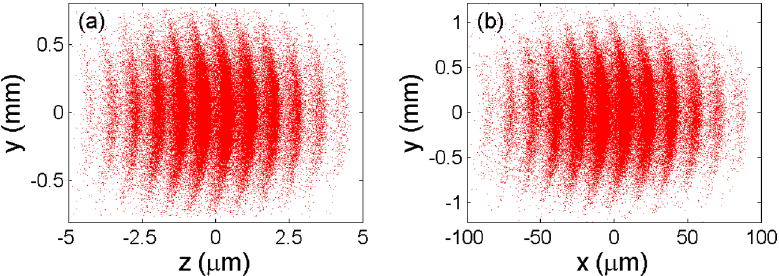
FIG. 7. (a) Initial z (cid:1) y correlation. (b) Final x (cid:1) y correlation after